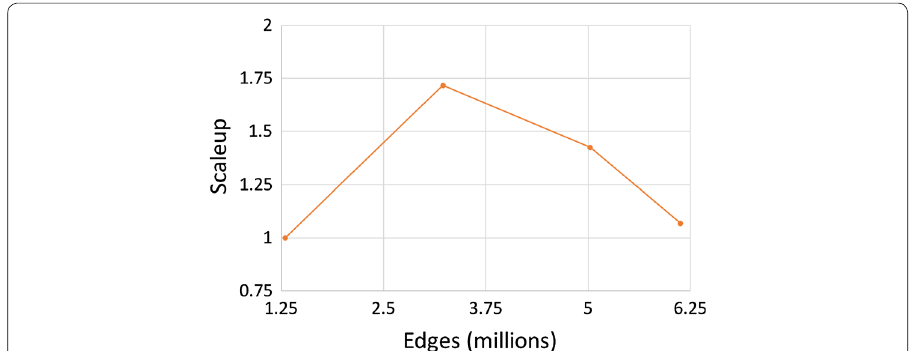
Fig. 8 DENCAST-local vs DENCAST-distributed. Scaleup factor measured with different sizes of the PVNREL dataset (1.25 M, 3,75 M, 5 M, 6.25 M edges) and increasing number of cores (8, 16, 24,